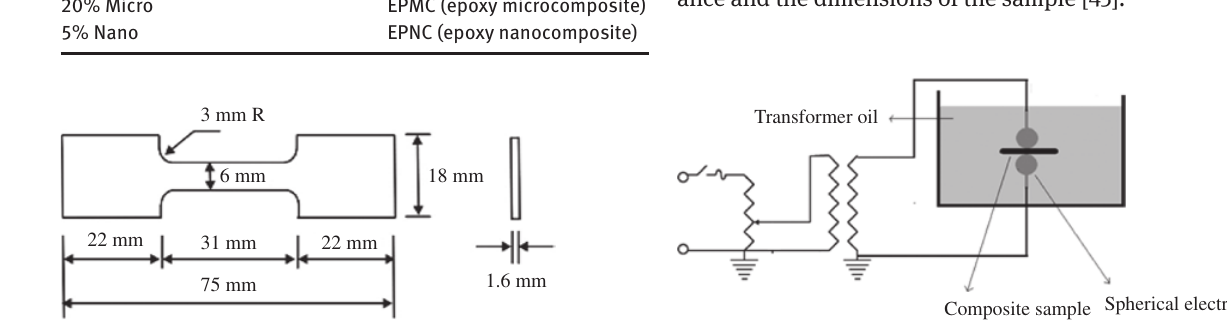
Figure 2: Schematic for breakdown